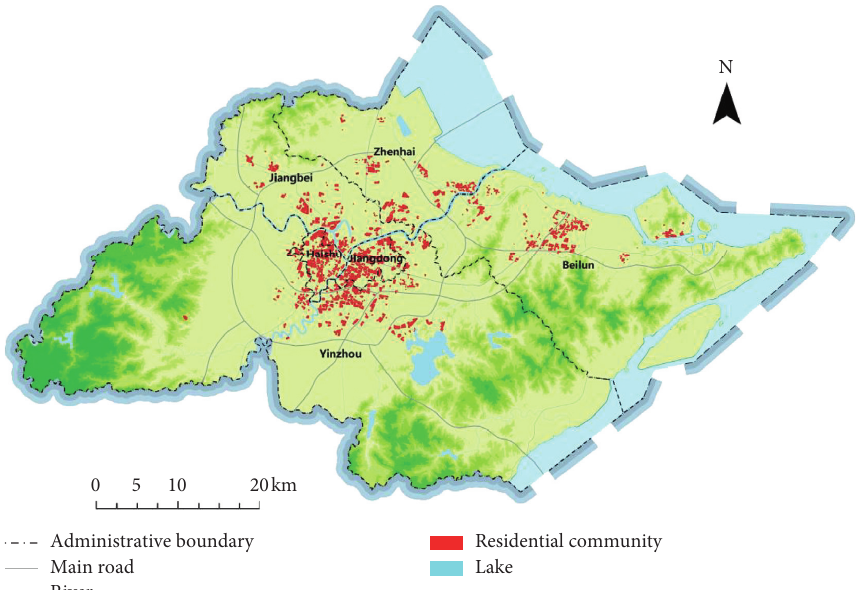
Figure 1: The basic geographical condition of the study area and the location of 1394 residential communities.